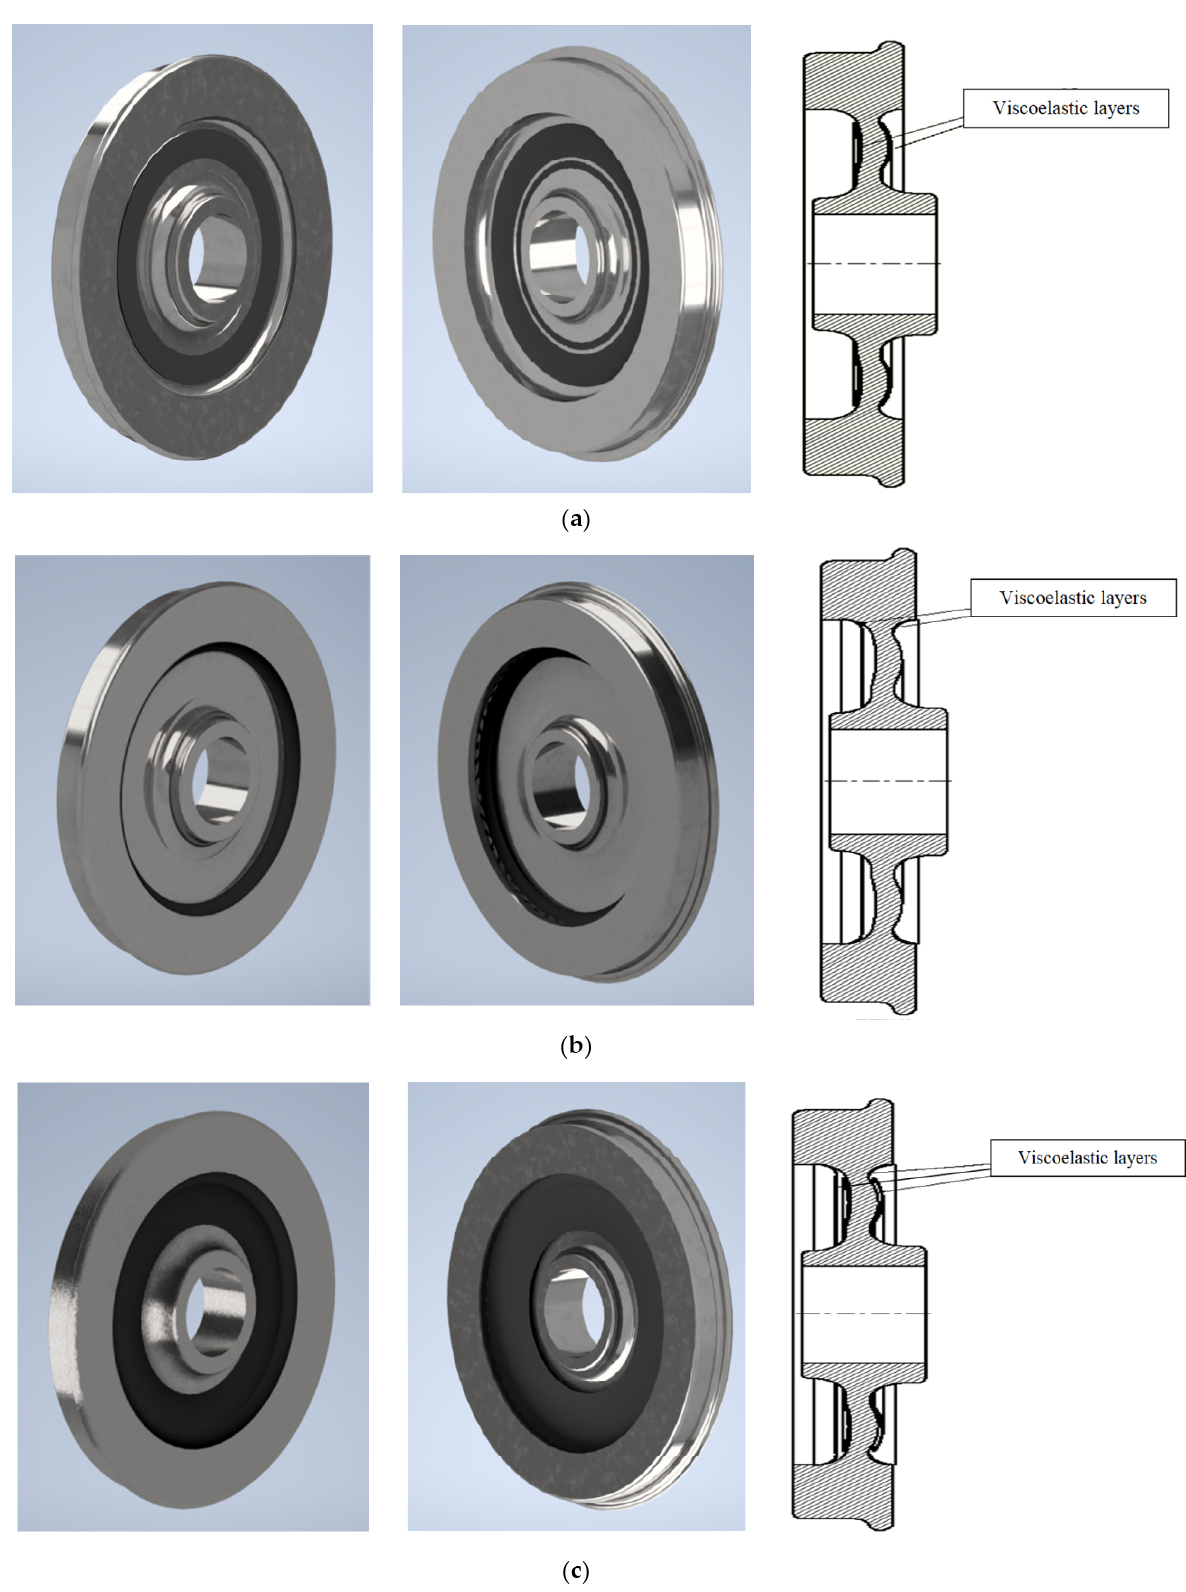
Figure 8. ( a ) Viscoelastic layer on the webs. ( b ) Viscoelastic layer under the rim. ( c ) Viscoelastic layer on the webs and under the rim.